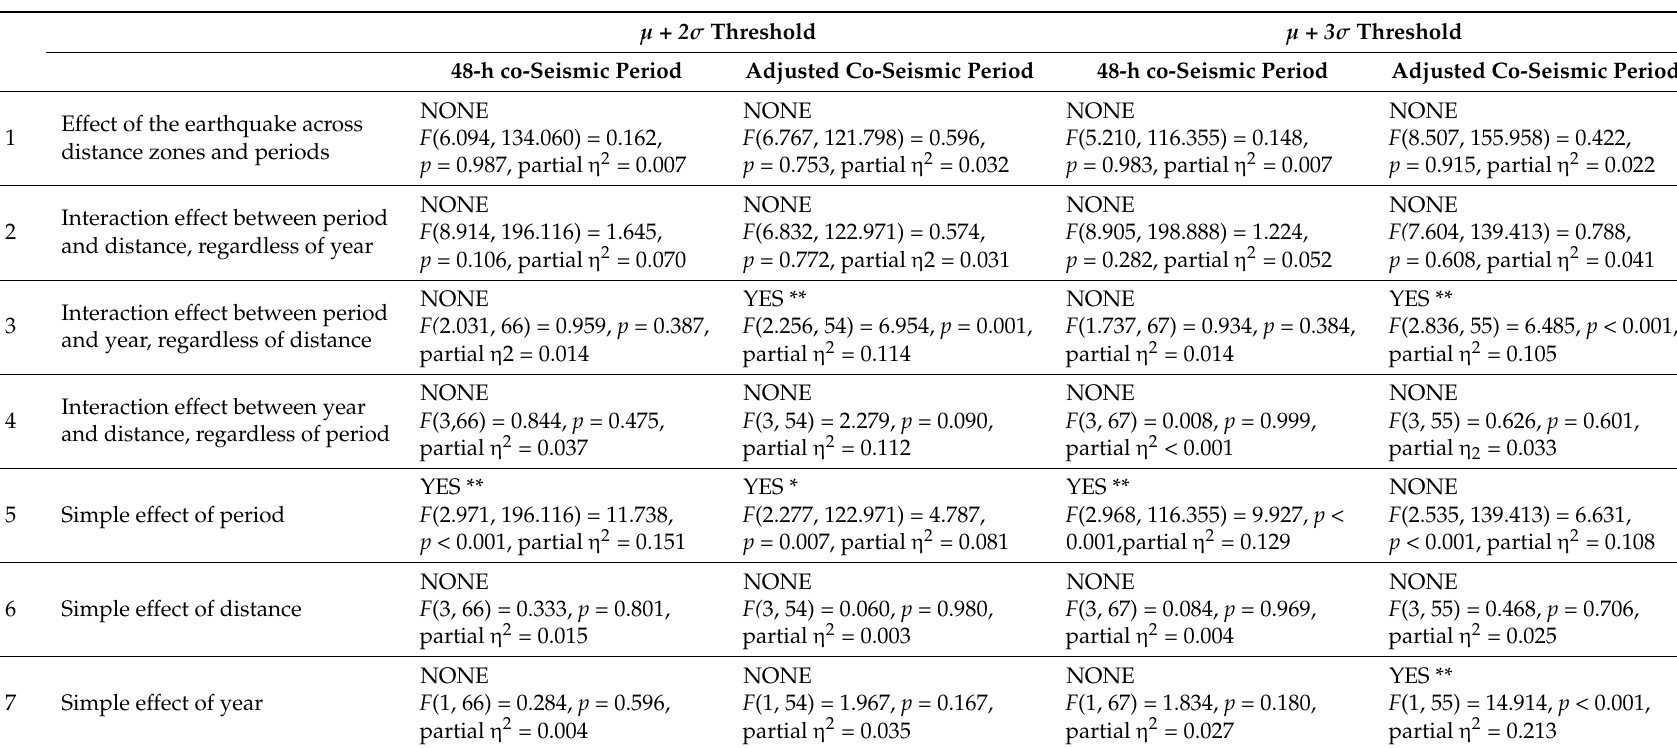
Table 3. Summary of the results of statistical tests . F- values show which part of the variance observed in the sample results from a specific effect or interaction, rather than from chance. The p- value is an expression of the probability of obtaining the calculated values when no (interaction) effect is present. Partial η 2 is a measure of the size of an observed statistically significant effect, denoting how much the effect contributes to the total variation in the sample. More information on ANOVA can be found, for example, in Maxwell et al. [58]. Significant effects are denoted with *( p < 0.05) or ** ( p < 0.001). µ + 2 σ